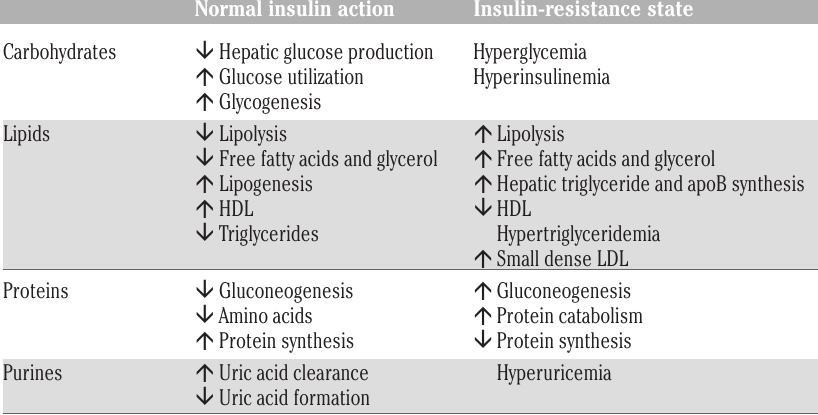
Table 5. Metabolic effects of insulin and consequences of insulin resistance. Normal insulin action Insulin-resistance state